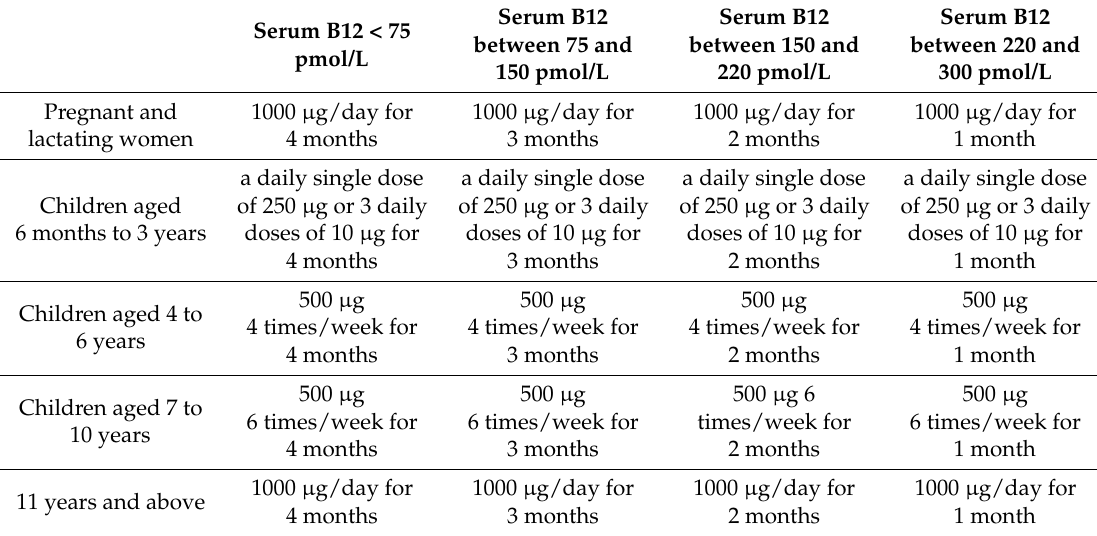
Table 3. Proposal of an oral supplementation scheme for vitamin B12 deficiency in pregnant and lactating women, infants, and